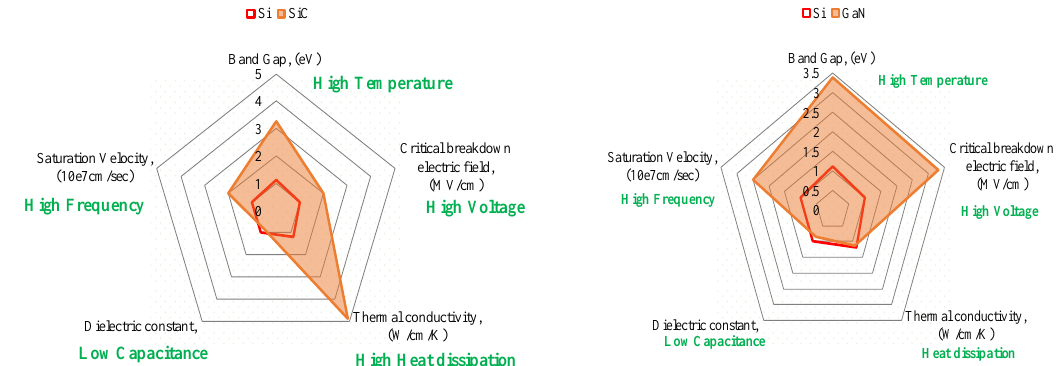
Figure 22. Parameter comparison of Si with respect to SiC and